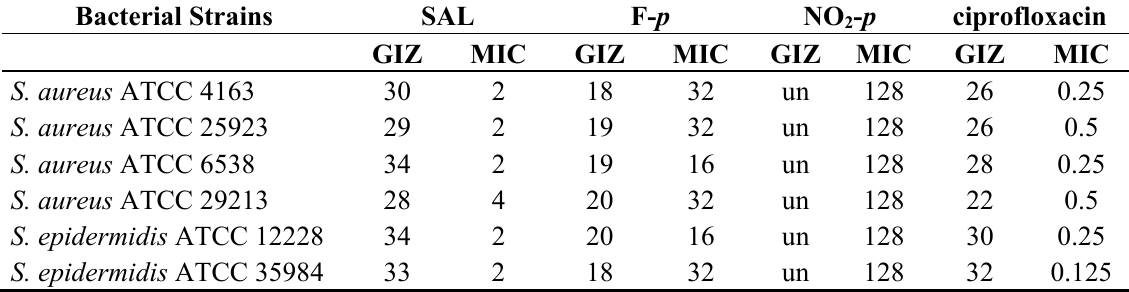
Table 5. Antibacterial activity of SAL as well as its F- p and NO ciprofloxacin, designated as diameter of GIZ (mm) and MIC (µg/mL). Bacterial Strains